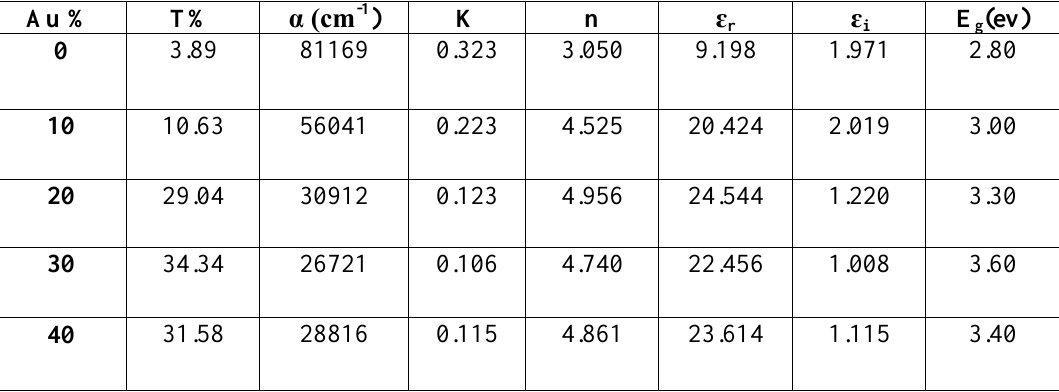
Fig. 18: The imaginary part of dielectric constant for pure WO 30 and 40) % thin films as a function of wavelength at T Table 4: The optical energy gap and the optical constants parameters for pure WO different doping of Au thin films at λ = 500